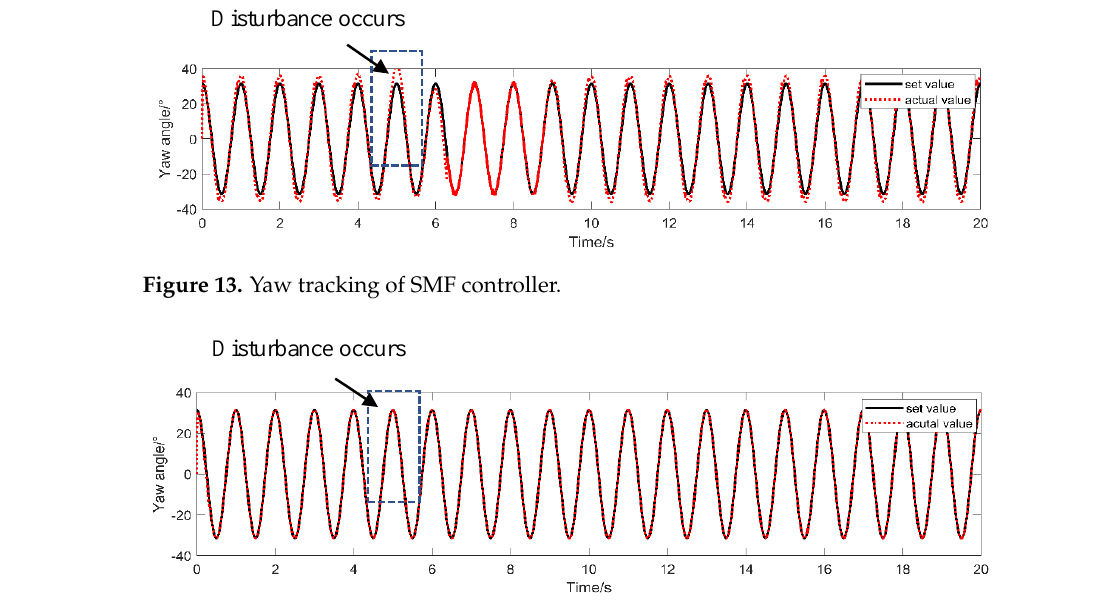
Figure 14. Yaw tracking of the standard sliding mode Figure 14. Y a w tracking of the standard sliding mode controller. Figure 14. Y a w tracking of the standard sliding mode controller.